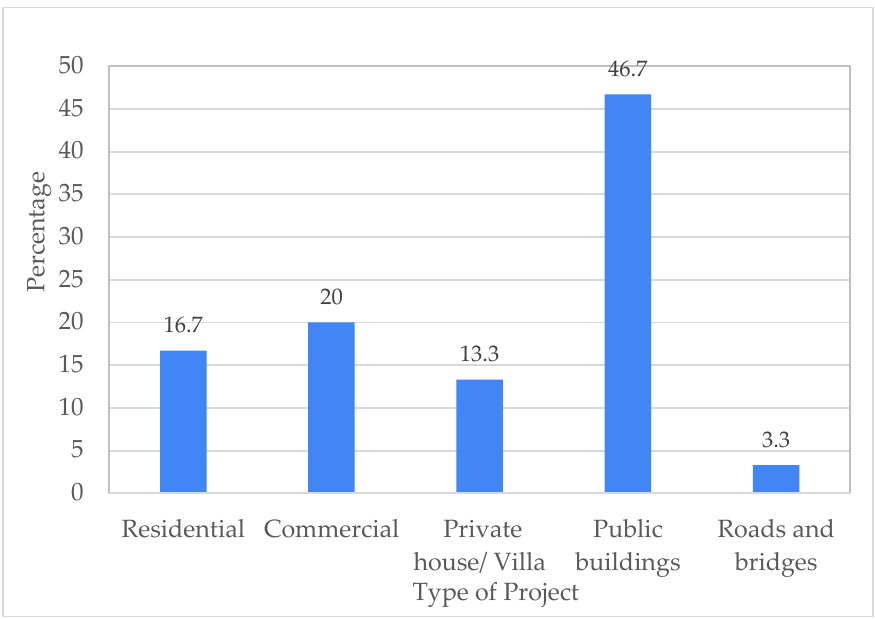
Figure 2. Experience of the participants in the survey.